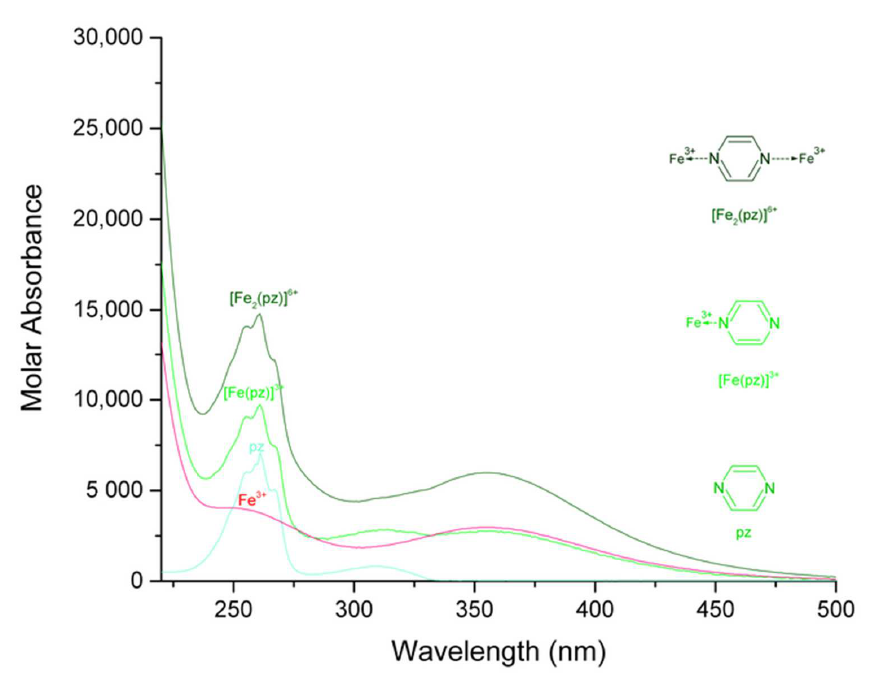
Figure 1. Calculated electronic spectrum of the solution system iron (III)-pyrazine in methanol: Fe 3+ , [Fe (pz)] 3+ , [Fe 2 (pz)] 6+ , and pz.